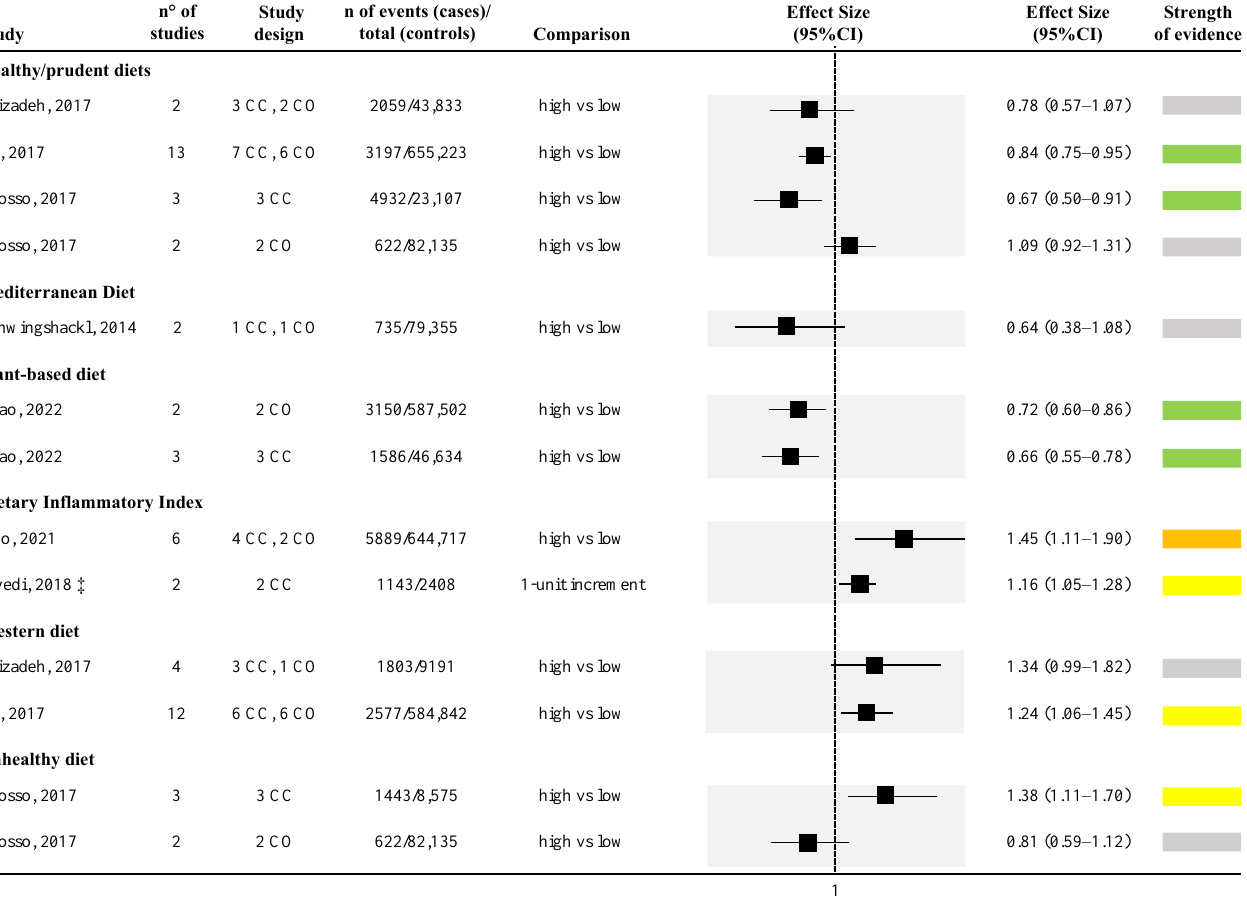
Figure 2. Forest plot of the meta-analyses assessing the association between dietary patterns and risk of pancreatic cancer [35,39,40,43,48,52,56]. Highly suggestive evidence was identified in two meta-analyses assessing the as- sociation between higher consumption of fruit and lower risk of PC [50,53]. The two meta-analyses included 11 and 21 observational studies, both obtaining approximately a 30% risk reduction [random effect size: 0.74 (95% CI; 0.63; 0.87), and 0.72 (95% CI; 0.63; 0.84), respectively] (Figure